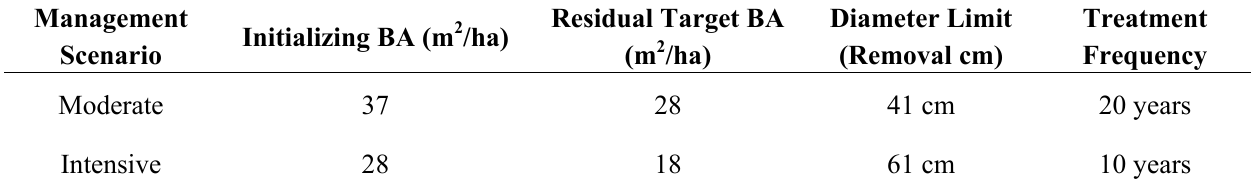
Table 2. Summary of Climate-FVS (Forest Vegetation Simulator) parameters for management scenarios over the 100 year simulation